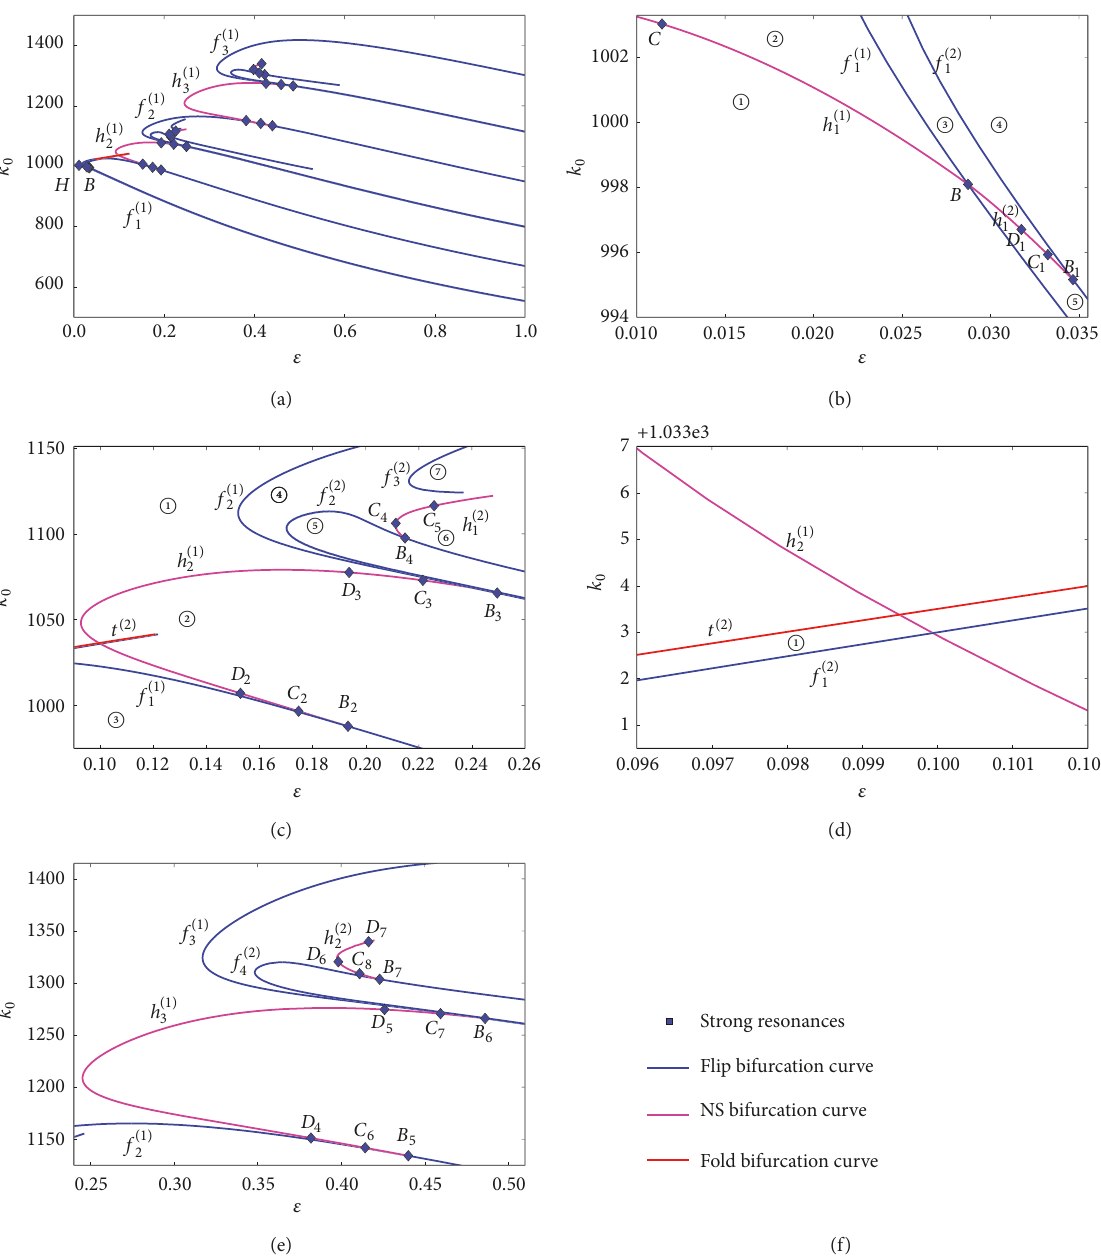
Figure 6: Bifurcation diagrams of system (28a), (28b), (28c), (28d), and (28e) for 𝑎 = 0.1, 𝑏 = 1000.1, 𝑉 𝑝𝑙 = 0.02 . (b), (c), and (e) Partial enlargements of (a); (d) partial enlargement of (c); (f) meanings of the symbol and